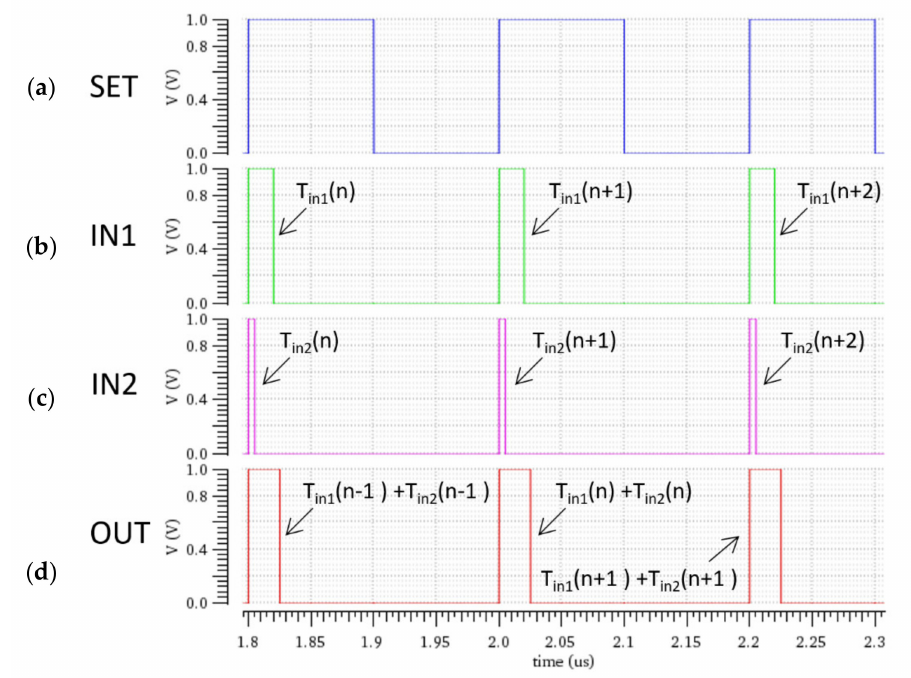
Figure 12. Timing waveforms for a 2-input z − 1 adder, ( a ) synchronization clock, ( b ) first input pulses with pulse width T in 1 = 20 ns, ( c ) second input pulses with pulse width T in 2 = 5 ns and ( d ) output pulses with pulse width T out = 25.08 ns.